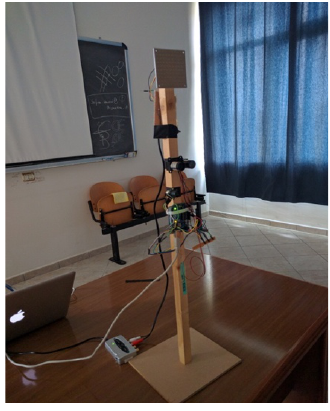
Figure 5. First Experimental setup